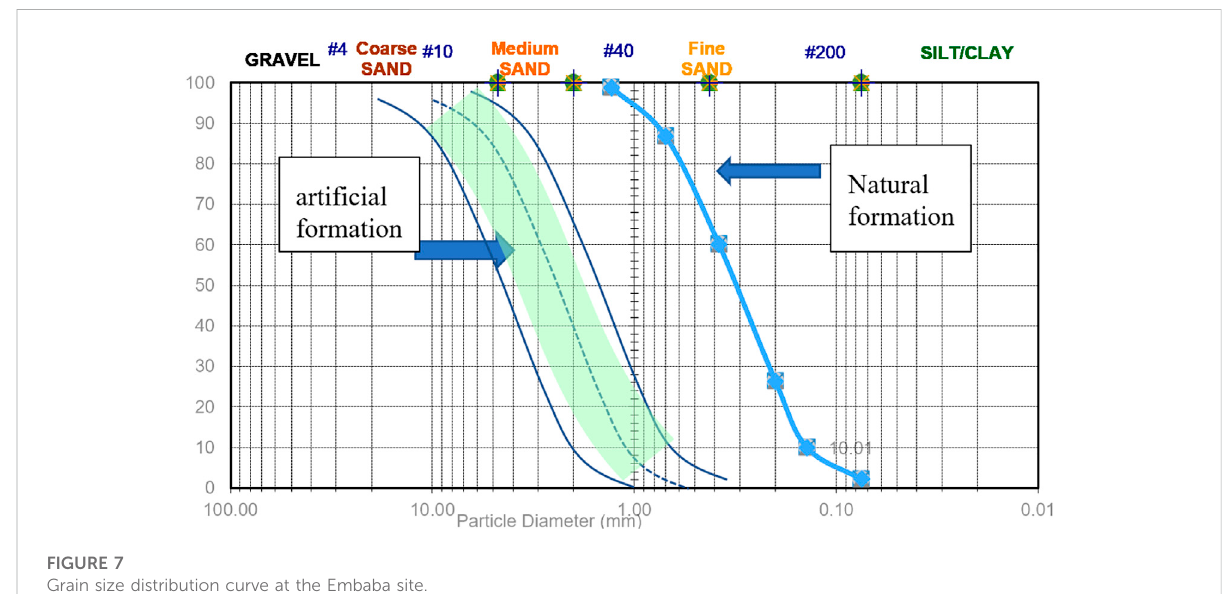
FIGURE 7 Grain size distribution curve at the Embaba